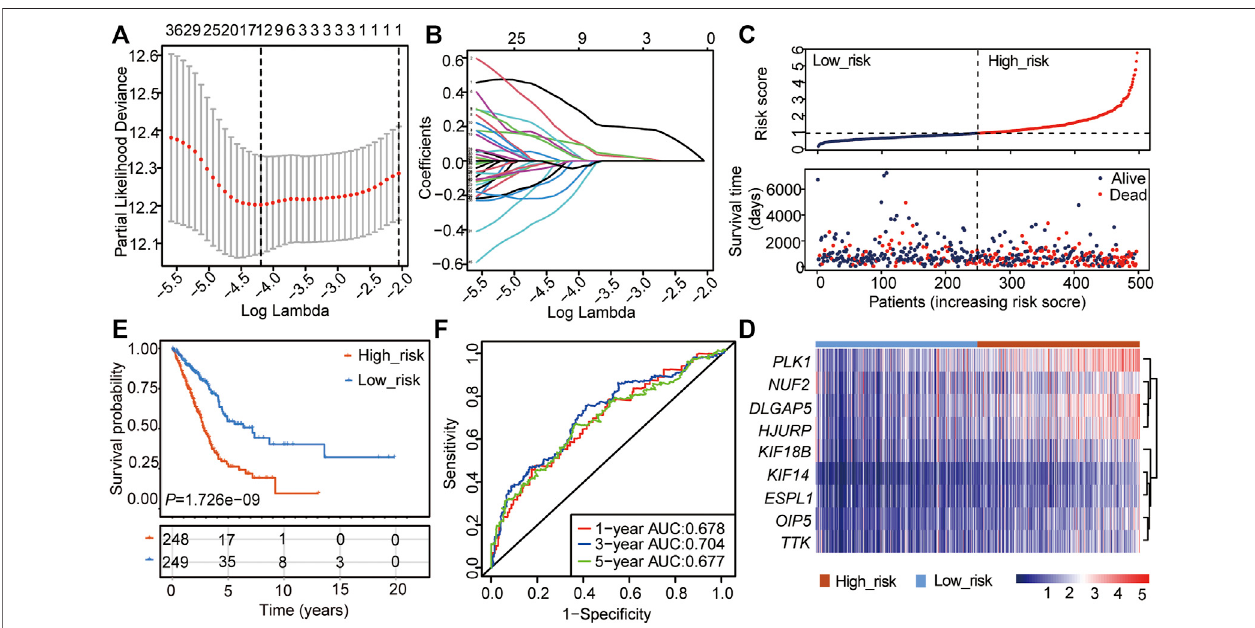
FIGURE 2 | Construction of the cox regression model by the 48 CSRs. (A) LASSO coef fi cient spectrum of prognostic gene screening. (B) Stepwise Cox proportionalriskregressionmodeltoscreentheprognosticgenes. (C) Theriskscoredistributionandsurvivalstatusofpatientsinthetrainingcohort. (D) Theheatmapof prognostic gene distribution in the training cohort. (E) The overall survival of high- and low-risk groups. (F) ROC analyses of the cox model for 1-, 3-, and 5-years.